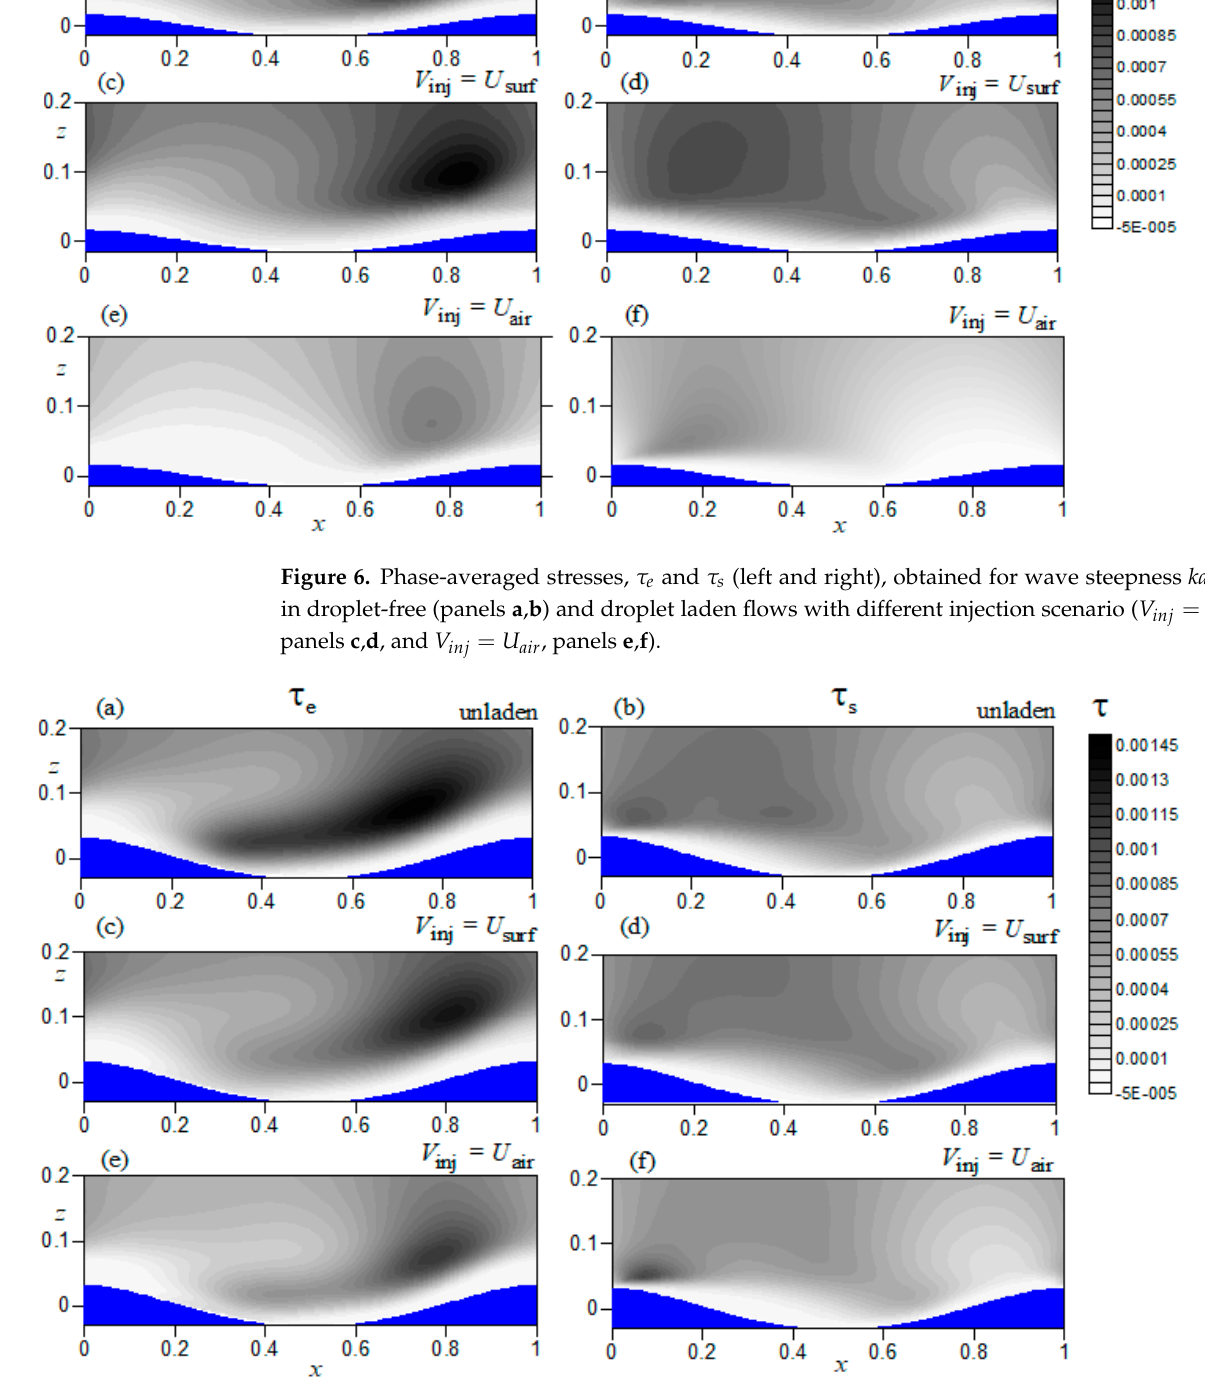
Figure 7. The same as in Figure 6, but for wave steepness ka = 0.2.